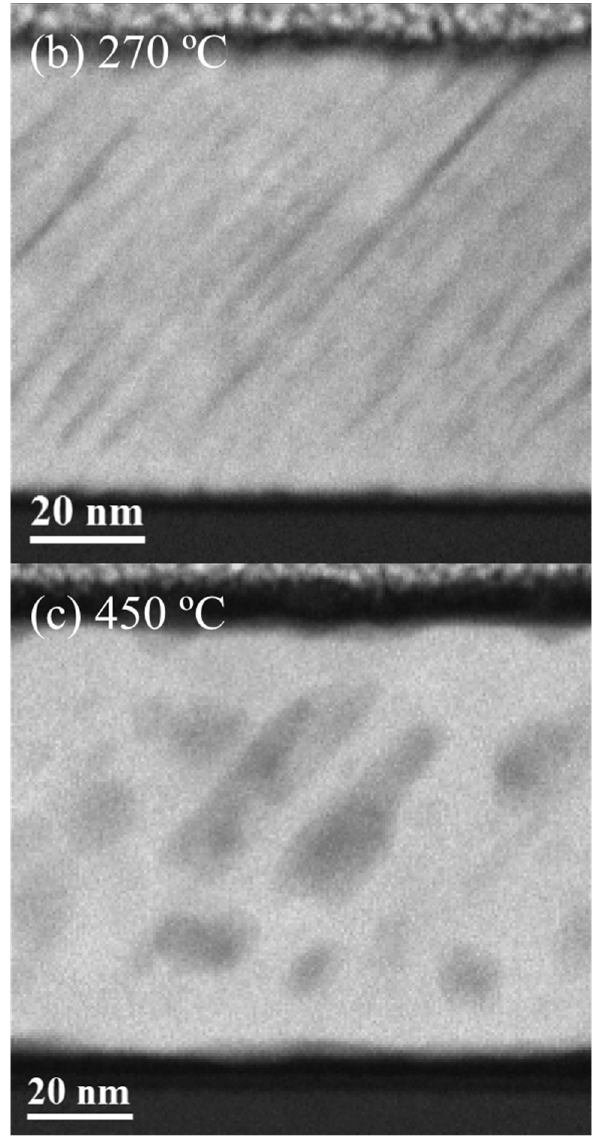
Figure 7. Cross-sectional HAADF-STEM images of an obliquely deposited Co film: ( a ) in the as-deposited state; ( b ) annealed at 270 °C and ( c ) annealed at 450 °C.